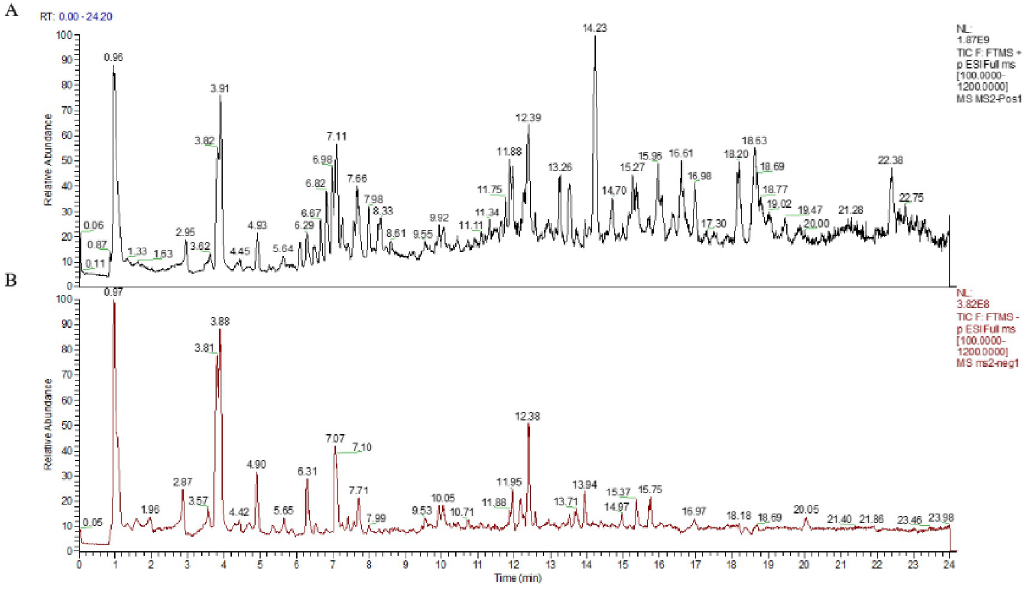
Fig 2. The total ion chromatograms (TICs) of AJH (A. positive ion mode. B. negative ion mode).